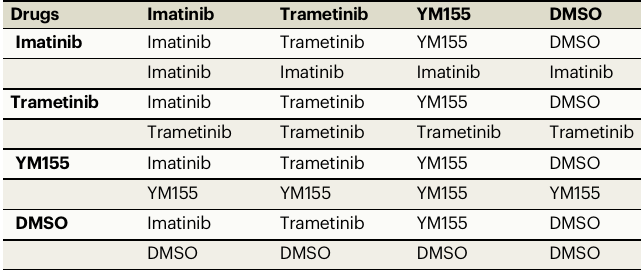
Table 1 | Matrix of drugs used in the combinatorial 4 × 4 screen